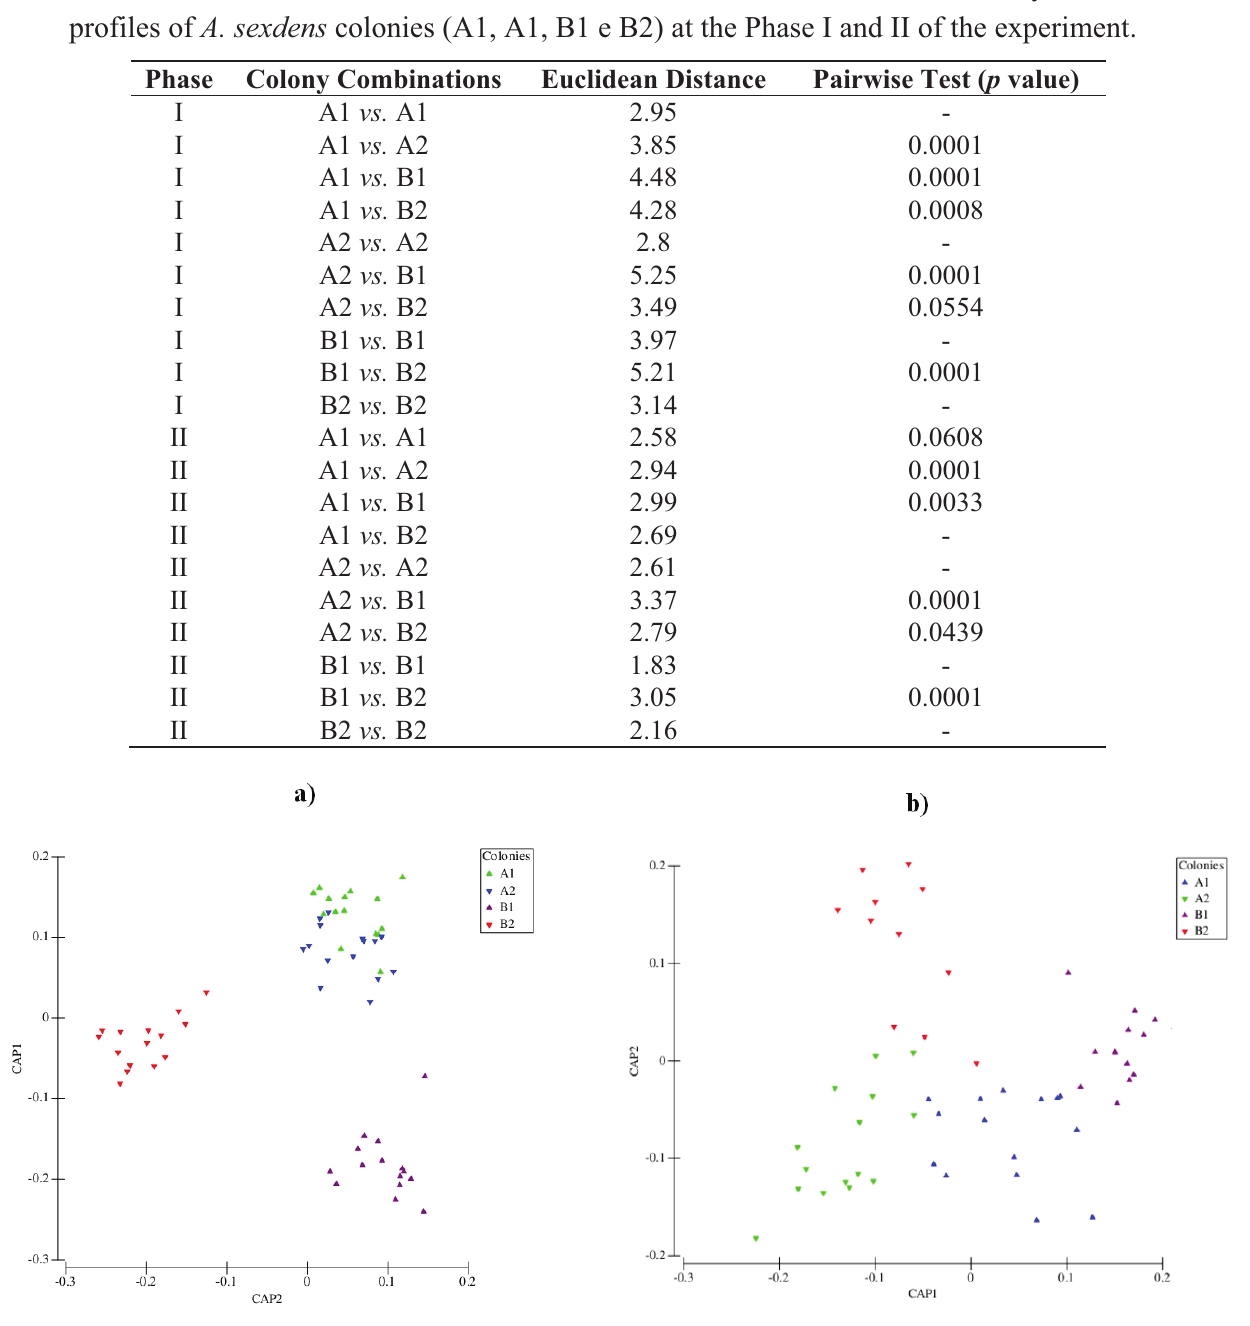
Figure 3. Result of canonical analysis of principle coordinates carried out with cuticular hydrocarbons of four Atta sexdens colonies at ( a ) Phase I and ( b ) Phase